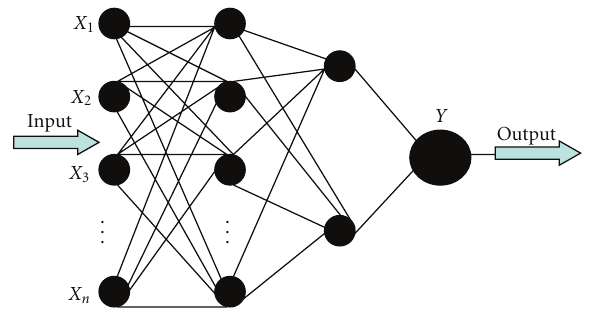
Figure 6: The probabilistic neural network.